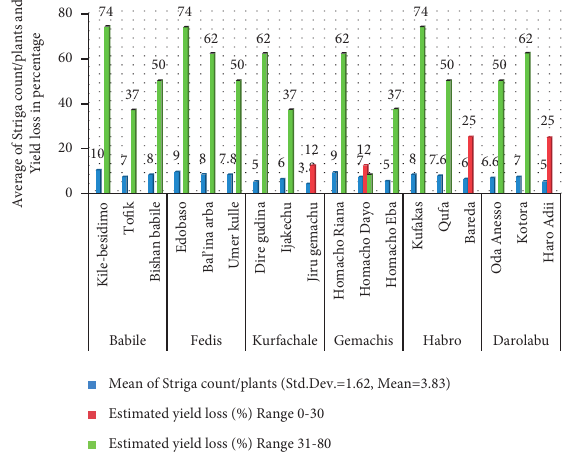
Mean of Striga count/plants (Std.Dev.=1.62, Mean=3.83) Estimated yield loss (%) Range 0-30 Estimated yield loss (%) Range 31-80 Figure 2: Assessment of estimated sorghum yield loss in surveyed districts.